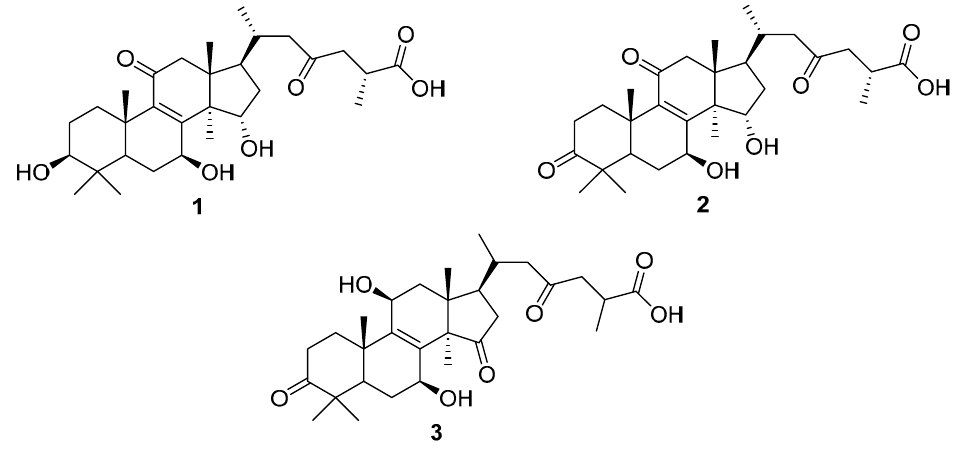
Figure 1. Triterpenes from G. lucidum.